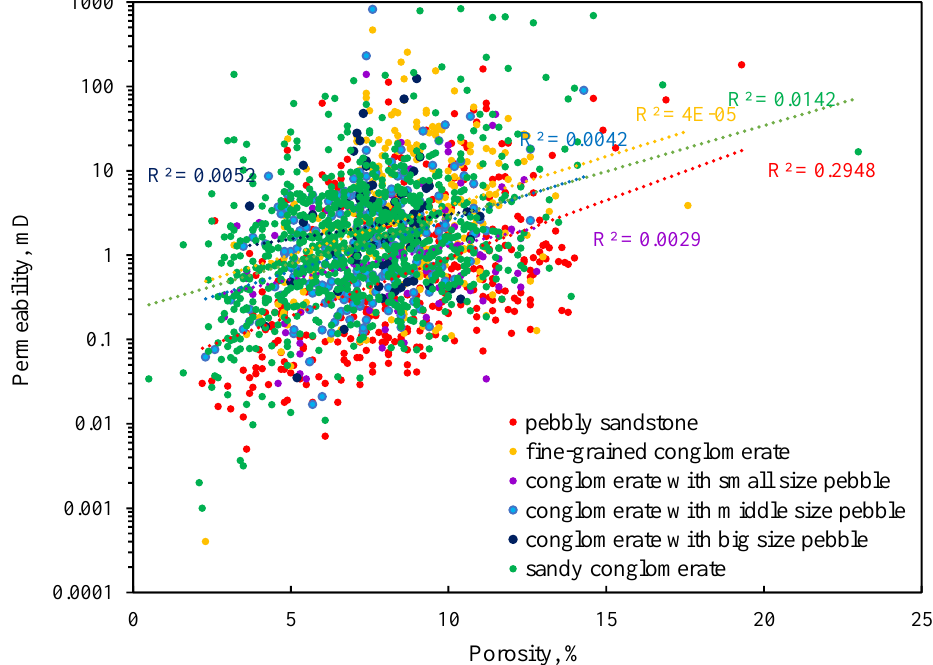
Figure 2. Distributions of porosity and permeability in the Mahu area. (( A ). Porosity; ( B ). Permeability).